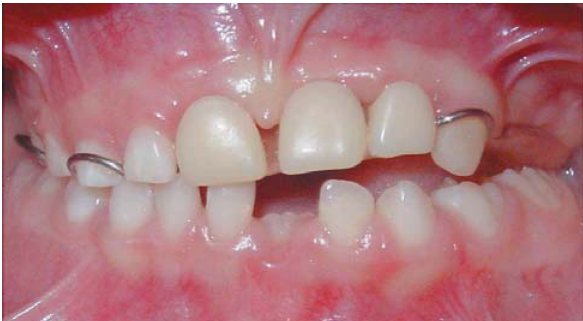
FIGURE 8- Rehabilitation of the child with temporary maxillary partial acrylic denture